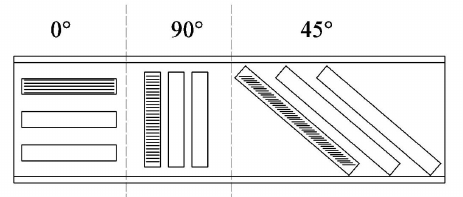
Figure 7: The three samples with different fiber orientations.